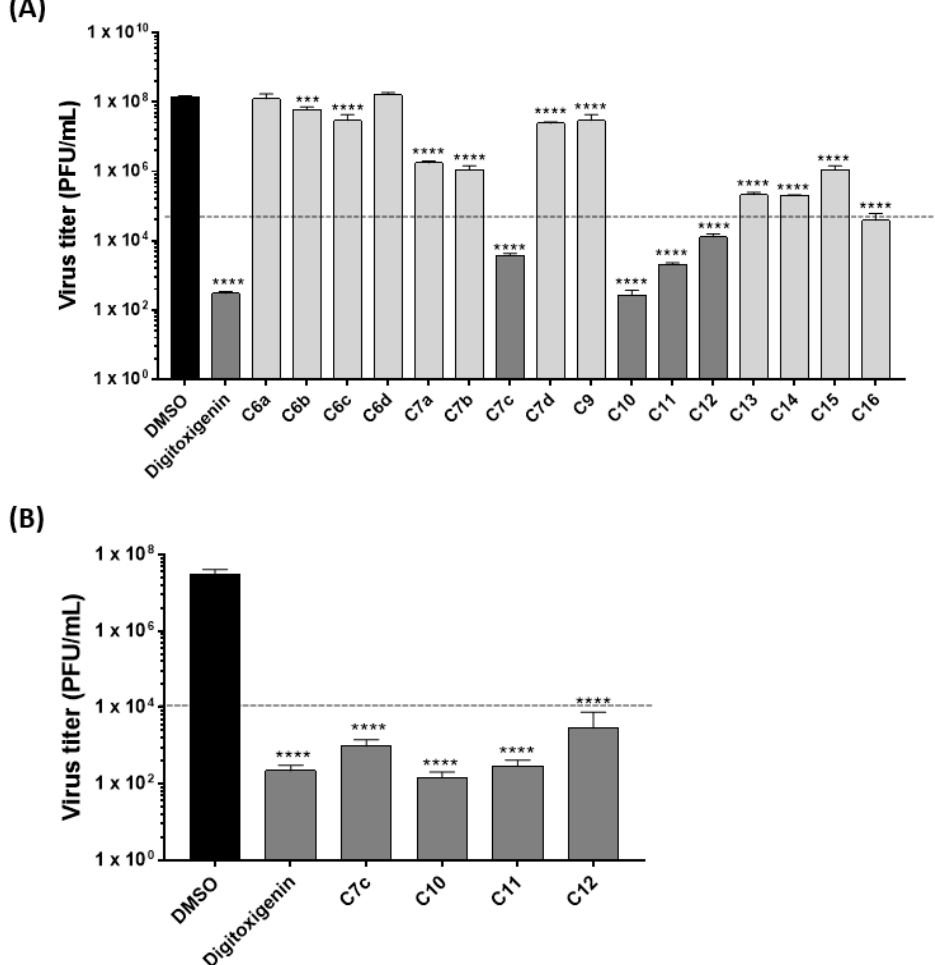
Figure 1. ( A ) Antiviral activity of new cardenolide derivatives ( C6a , C6b , C6c , C6d , C7a , C7b , C7c , C7d , C9 , C10 , C11 , C12 , C13 , C14 , C15 , and C16 ) and the scaffold digitoxigenin against influenza A virus (strain A/WSN/33 (H1N1)). A549 cells were infected at MOI 0.01 for 1 h and further treated with 1 µM of the compounds. Supernatants were collected at 24 h post-infection (p.i.) and titrated on Madin-Darby canine kidney (MDCK) cells. The black line indicates the compounds that reduced >50% of viral titer. Dimethyl sulfoxide (DMSO) served as solvent control and the titers of DMSO-treated cells were arbitrarily set to 100%. ( B ) Antiviral activity of the most active compounds in the preliminary screening (digitoxigenin, C7c , C10 , C11 , and C12 ) using the same experimental conditions cited above for ( A ) on MDCK cells. *** p < 0.001 and **** p < 0.0001 vs. DMSO, one-way ANOVA, post hoc test Dunnet.